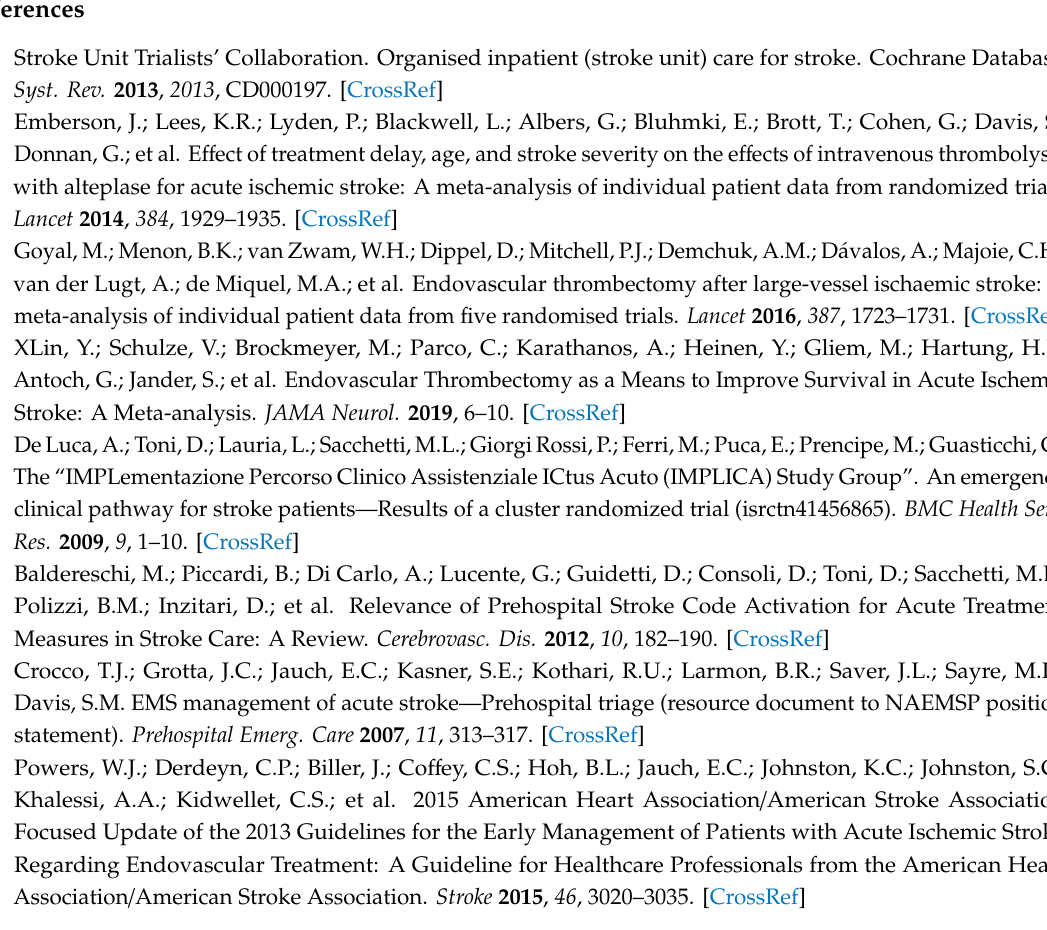
Figure S1: Summary table RACE Scale and Instructions to evaluate the RACE scale, S2: satisfaction survey, S3: knowledge-related multiple-choice